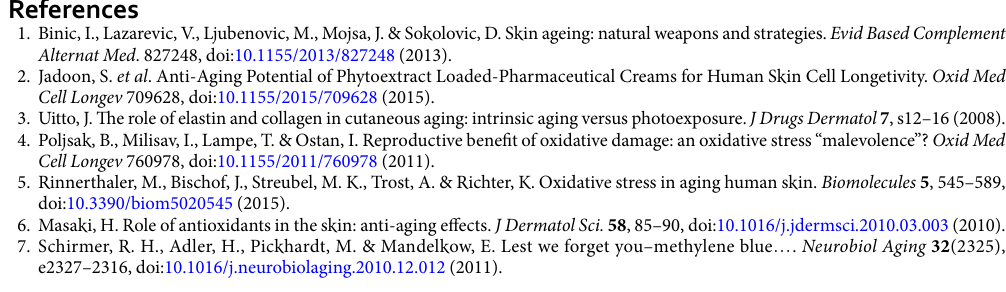
(Fig. 3A, Lower Panel). Both types of cells are cultured to form a multilayered model of the human dermis and epidermis that are mitotically and metabolically active. EFT-412 skin tissue is an ideal in vitro system to study the anti-aging efficacy of cosmetic ingredients and formulations, and is applied in the following